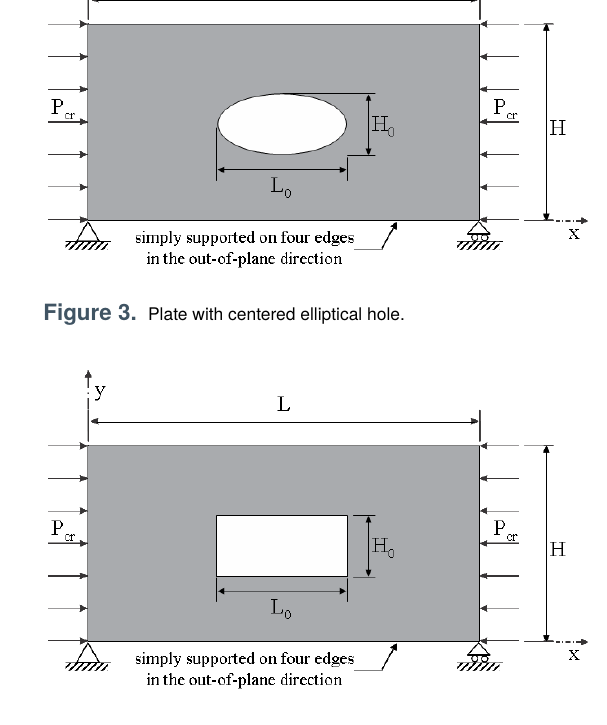
Figure 4. Plate with centered rectangular hole.